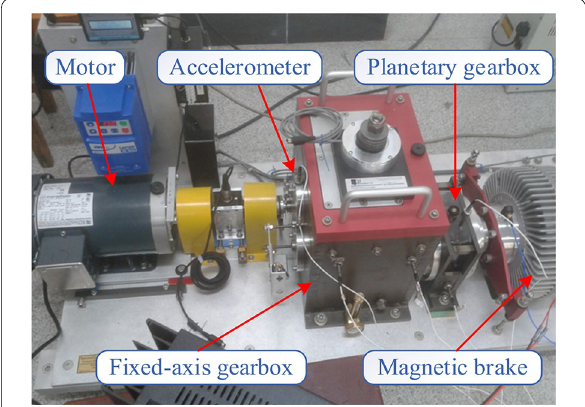
Figure 6 Test bench for vibration signal acquisition of gearbox